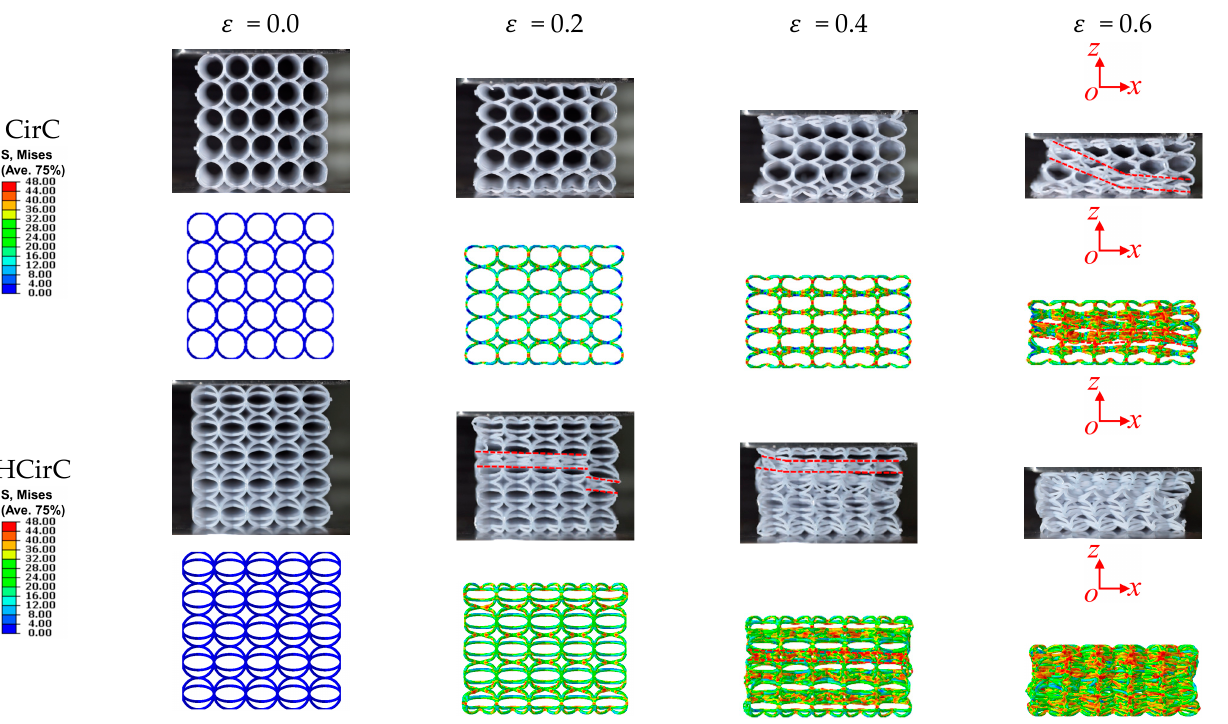
Figure 12. The compression behaviors of BCC, CirC, and HCirC (in XZ-views, and the compression direction is along the z -axis).